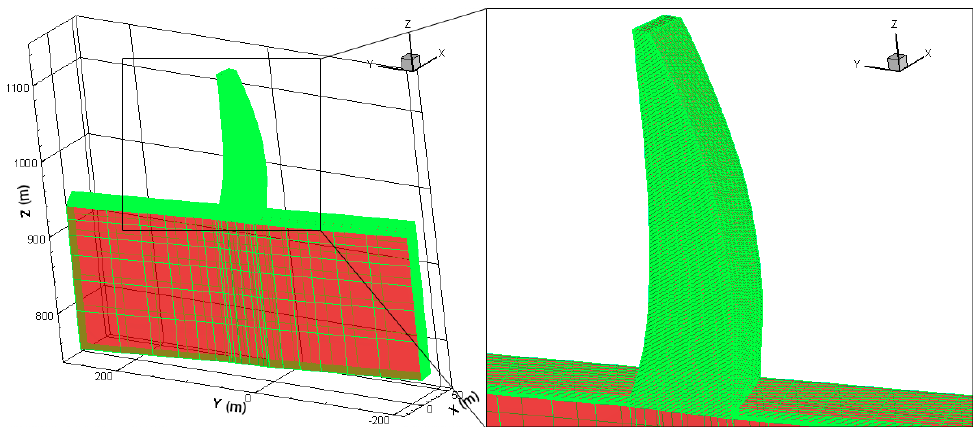
Figure 9. 3D FE mesh model of the #18 dam section of Dagangshan Dam.